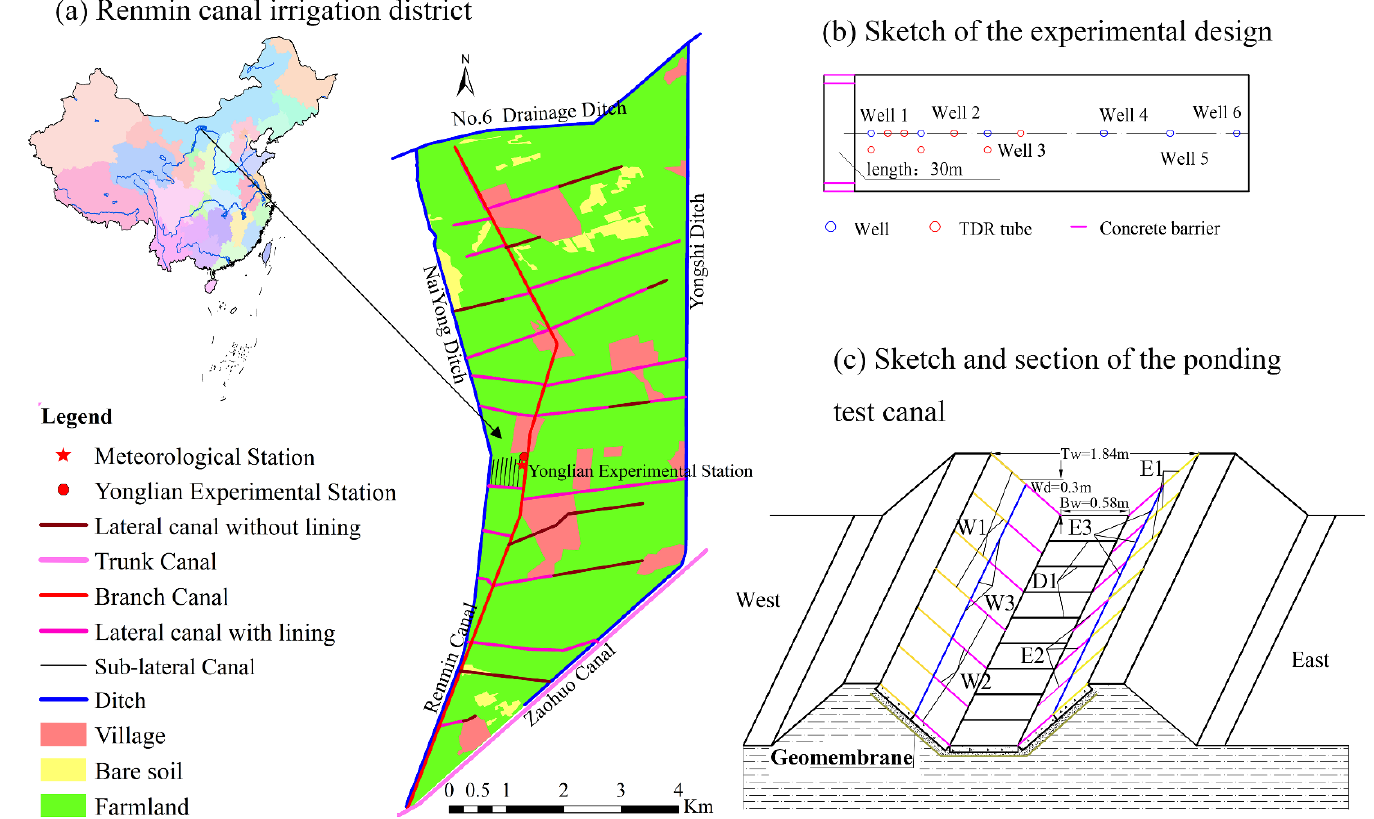
Figure 1. The study area location and detail information about ponding test. ( a ) The geographic location of the Renmin irrigation area. ( b ) Sketch of the experimental design. ( c ) Sketch and section of the ponding test canal. Note: D1 is the joints in the bottom of canal; “W1” and “W2” are the joints perpendicular to the direction of the canal in the upper and lower left side of the canal; “E1” and “E2” are the joints perpendicular to the direction of the canal in the upper and lower right side of the canal; “W3” and “E3” are the joints parallel to the direction of the canal in the left and right sides of the canal; “Tw” is the top width of canal; “Bw” is the bottom width of canal; “Wd” is the water depth in canal.